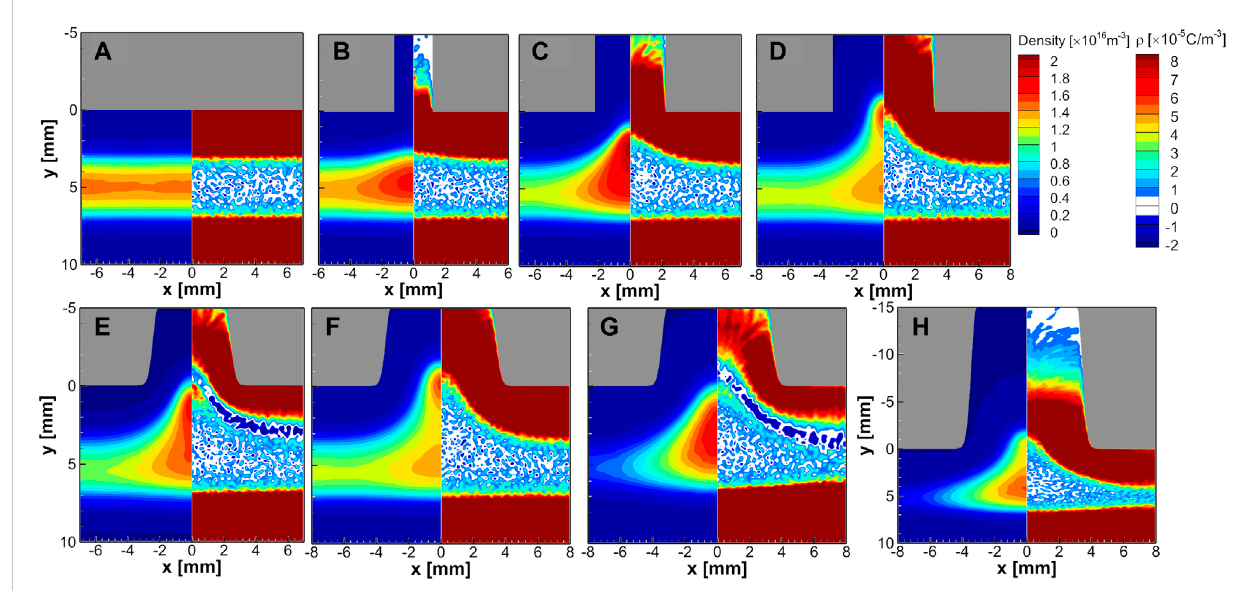
FIGURE 3 The time-averaged spatial pro fi les of the electron density (left side) and the space charge density (right side) obtained by changing the simulation conditions (A) withouttrenchorwithaninlettrenchsizeof (B) d =2 mm, (C) d =4 mm,and (D) d =6 mm, (E) d =4 mmwithGaussianshapeslope, (F) d = 6 mm with Gaussian shape slope with a hole depth of h = 5 mm at 1 Torr. In addition, (G) with a gas pressure of 0.6 Torr under the same condition as (F) , and (H) with a depth of h = 15 mm under the same condition as (G)